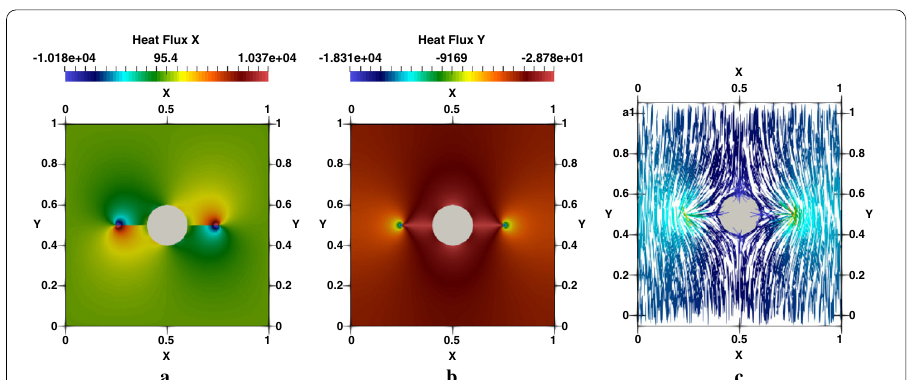
Fig. 16 Square plate with round hole R / L = 0 . 2, l / L = 0 . 3: a q x -heat flux, b q y -heat flux, c flux lines